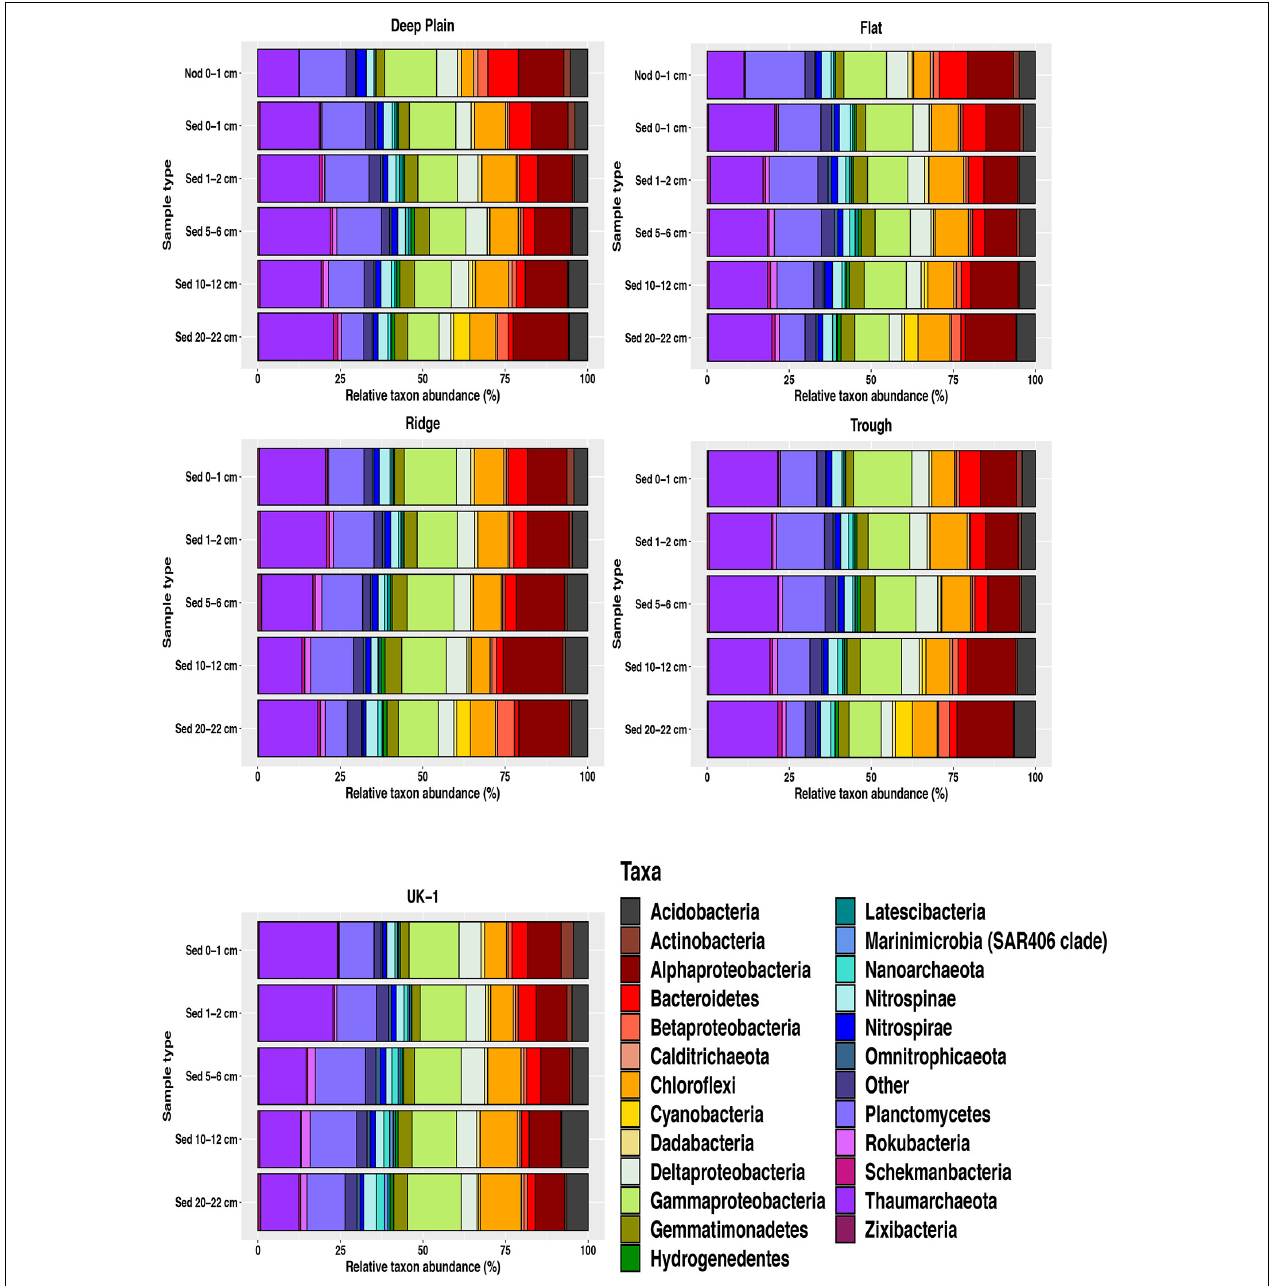
FIGURE 4 | Relative abundances of amplicon sequence variants (ASVS) at phylum level nodule-associated and sediment (0–22 cm) from APEI-6 and UK-1 in the CCZ. Nodules are from the surface sediments (0–1 cm) of the Deep Plain and Flat regions of APEI-6. Only taxa ≥ 1% relative abundance are shown. Category “Other” represents taxa < 1% relative abundance. Relative abundances were calculated on samples that had first been normalized to account for uneven sampling depth, by scaling sequence counts by library sizes.